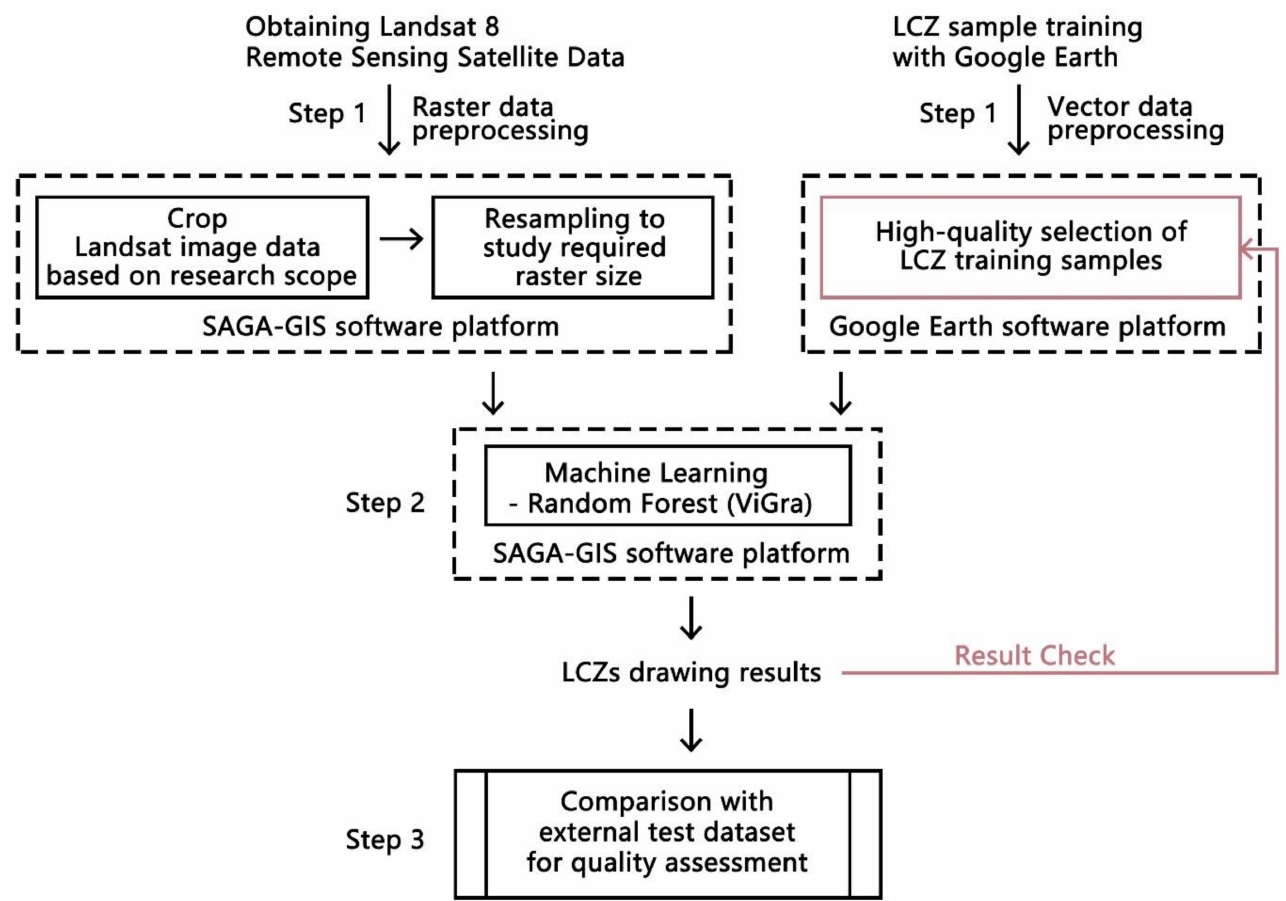
Figure 8. WUDAPT data collection